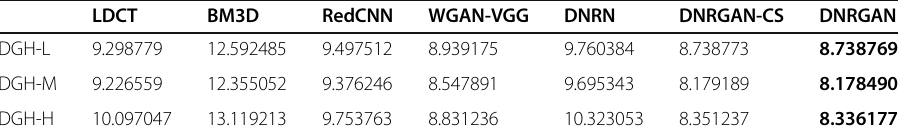
Table 4 The results of the FID for each methods on the DGH dataset LDCT BM3D RedCNN WGAN-VGG DNRN DNRGAN-CS DNRGAN DGH-L